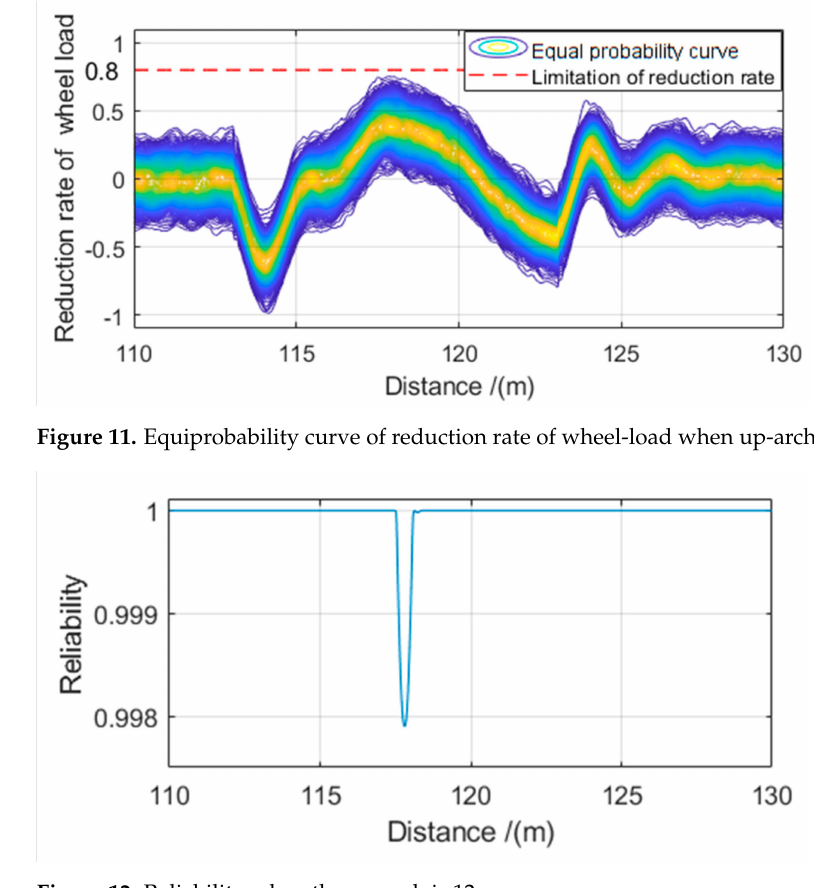
Figure 12. Reliability when the up-arch is 12